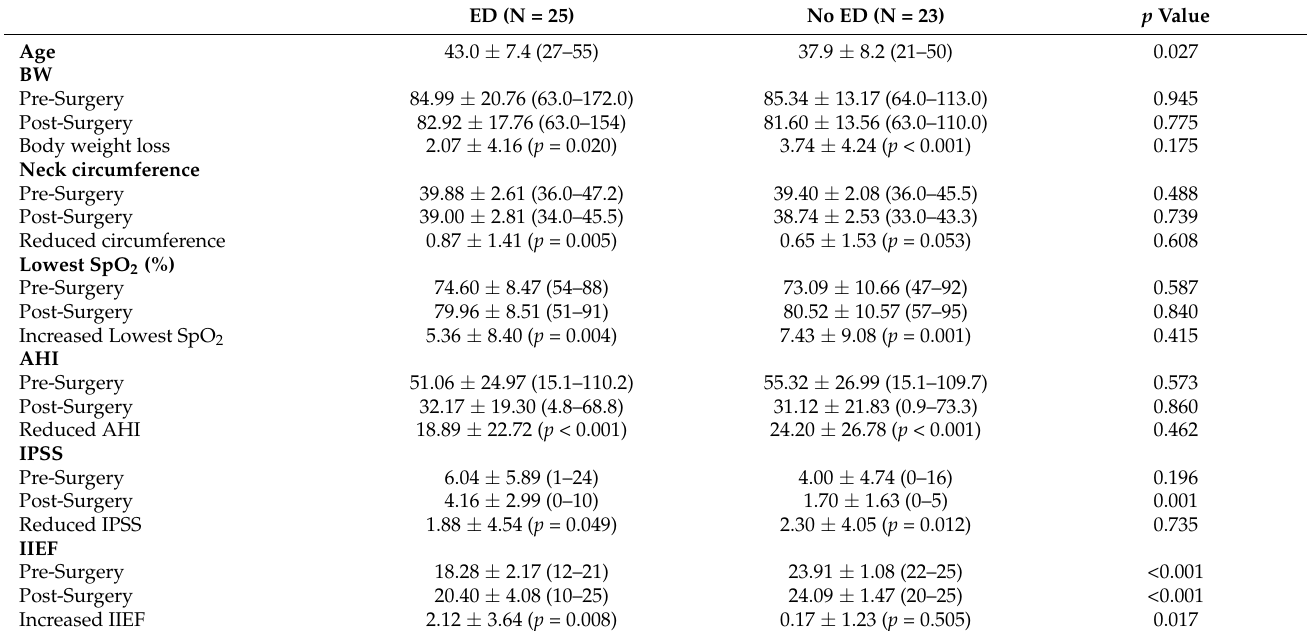
Table 5. Postoperative changes in the subgroup of patients with ED at baseline (IIEF ≤